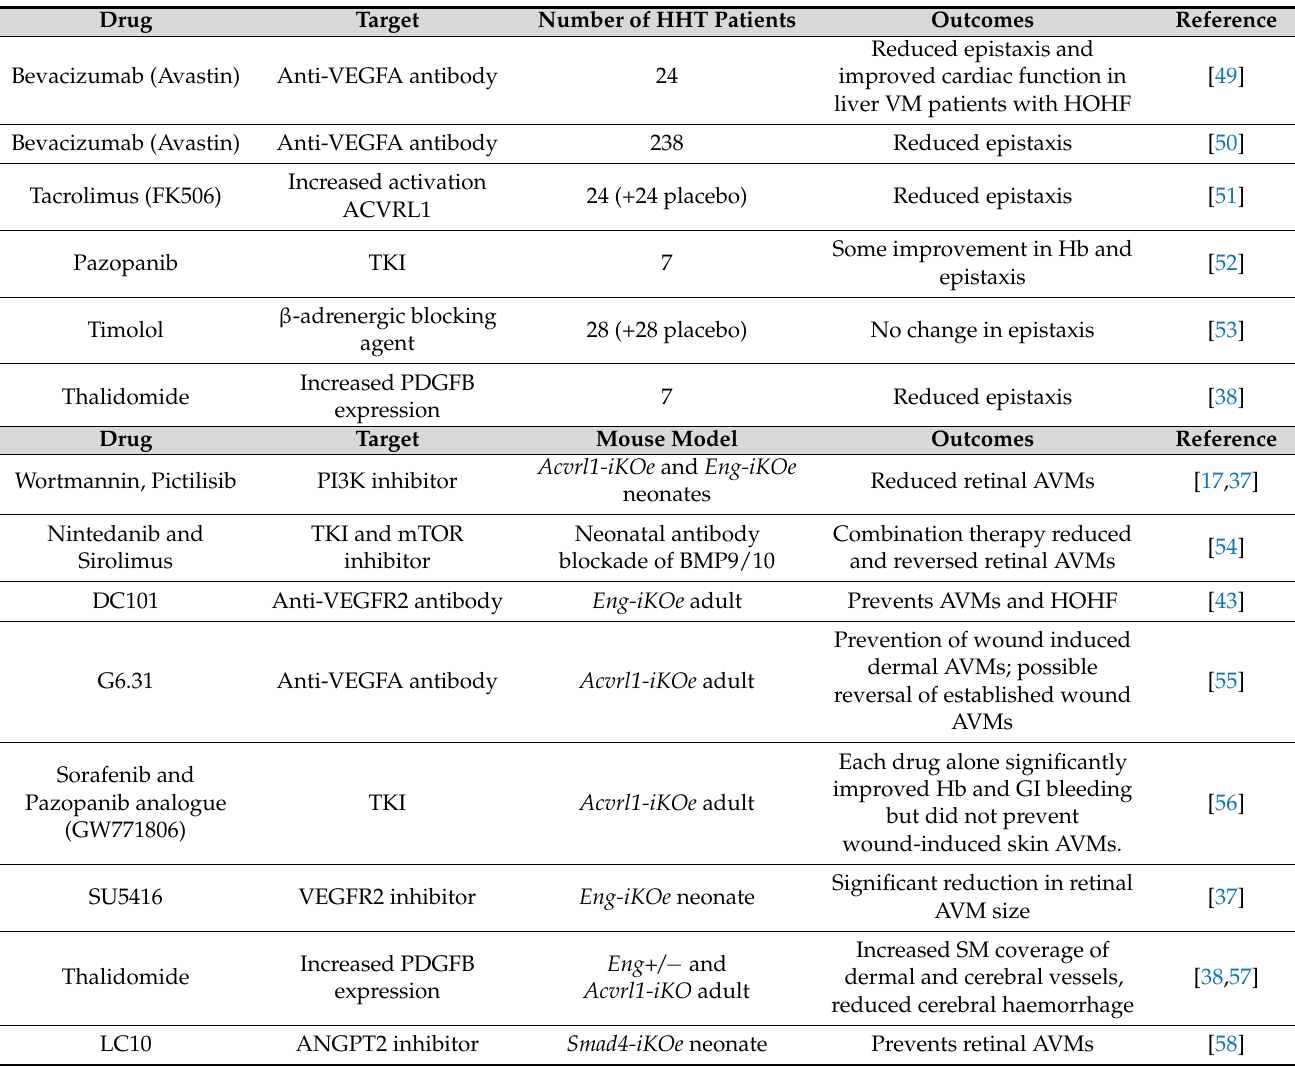
Table 1. Pharmaceutical rescue of Hereditary haemorrhagic telangiectasia (HHT)-related phenotypes in patients and preclinical